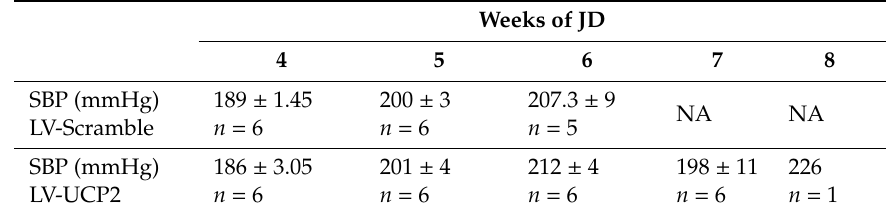
Table 2. Systolic Blood Pressure (SBP) in JD-fed SHRSP rats receiving a single i.c.v. injection, of either LV-UCP2 or empty vector (LV-Scramble). Weeks of JD